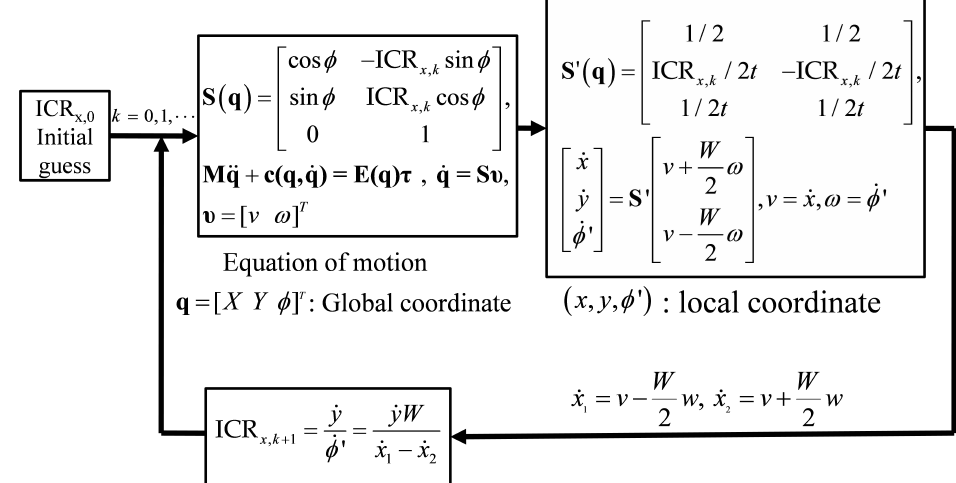
Figure 4. A scheme of the estimating the ICR under wheel slippage.